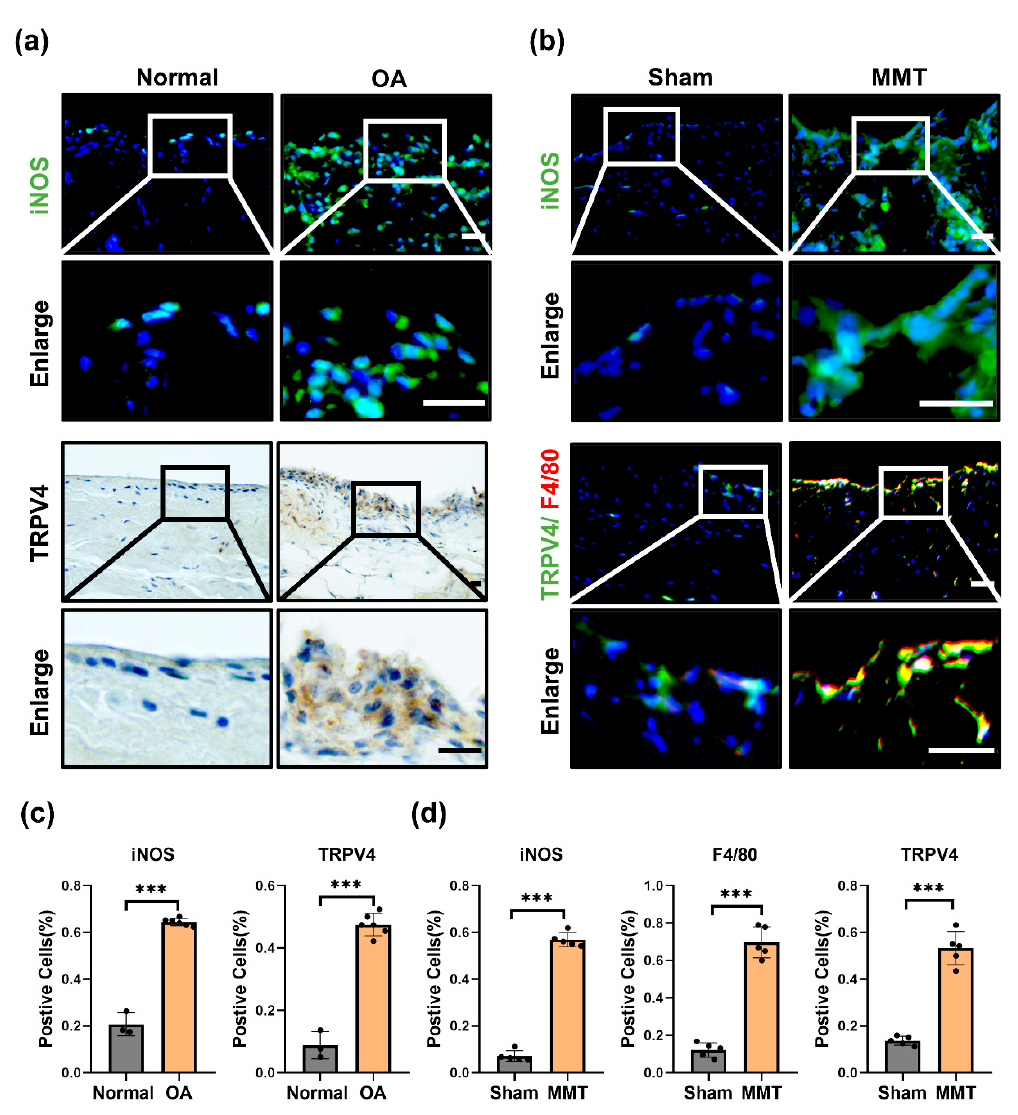
Figure 1. TRPV4 and M1 macrophages are elevated in OA synovium. ( a ) Immunofluorescence images of iNOS and immunohistochemical staining of TRPV4 in normal and OA human synovium (Scale bar: 50 µ m). ( b ) Immunofluorescence images of iNOS, TRPV4, and F4/80 in the sham and MMT rat synovium (Scale bar: 50 µ m). ( c ) Percentages of iNOS- and TRPV4-positive cells in human synovium. normal human synovium sample = 3, OA human synovium sample = 6. Unpaired two-tailed t -test, *** p < 0.001. ( d ) Percentages of iNOS-, F4/80-, and TRPV4-positive cells in sham and MMT group. n = 5. Unpaired two-tailed t -test, *** p < 0.001. All data are shown as mean ± SD.